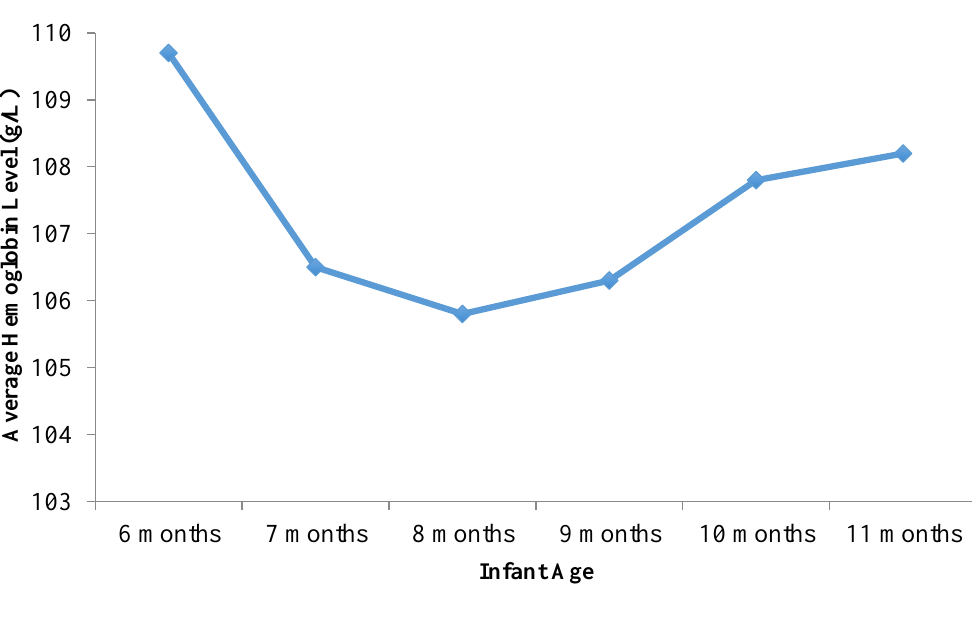
Figure 1. Hemoglobin levels in infants aged 6–11 months by age group in rural Shaanxi province, China, 2013.